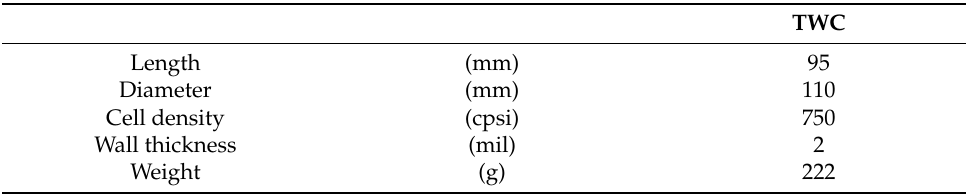
Table 4. Characteristics of the test monolith.